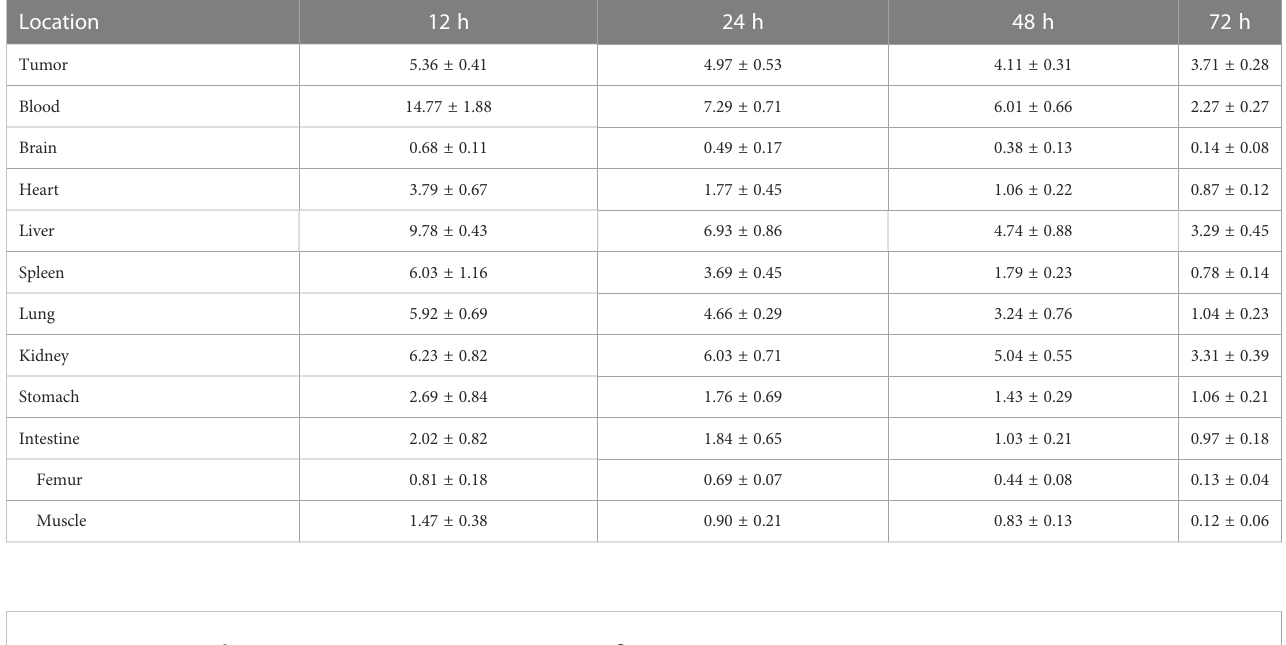
TABLE 2 Biodistribution of 131 I-PLGA-rhTSH in nude mice with thyroid cancer (% ID/g).